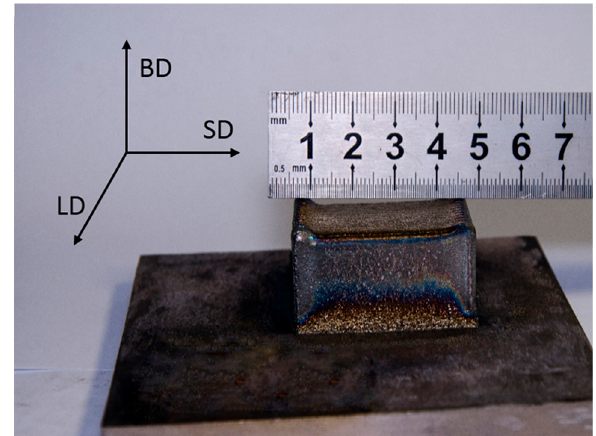
Figure 2. Bulk Ti–26Nb sample fabricated by laser additive manufacturing (LAM).